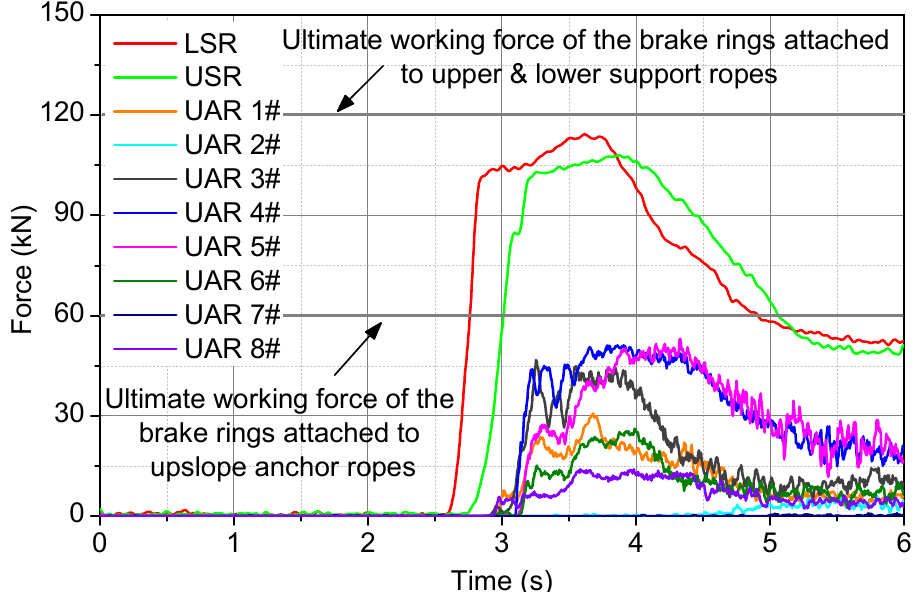
Figure 10. Internal forces of ropes of the flexible barrier (Note: UAR 1#~8# means the upslope anchor ropes from left to right).